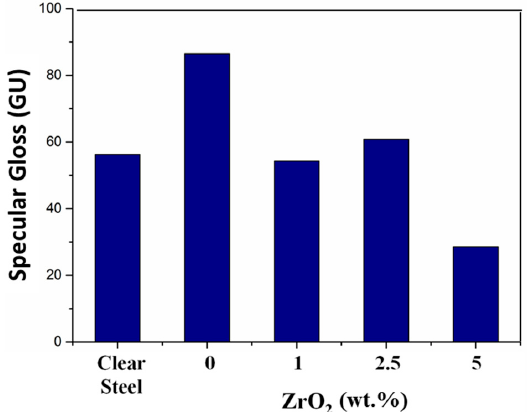
Figure 8. Variation of gloss as a function of the percentage of zirconia.